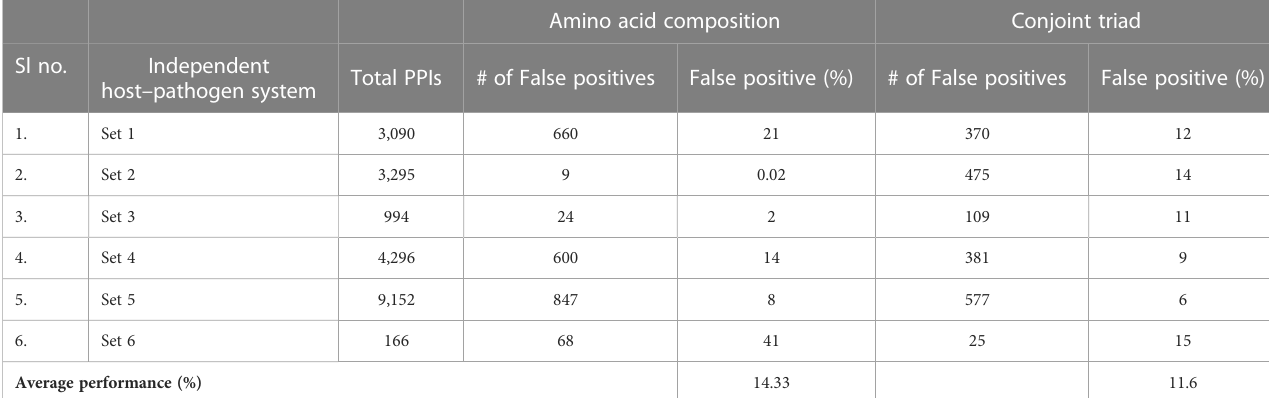
Amino acid composition